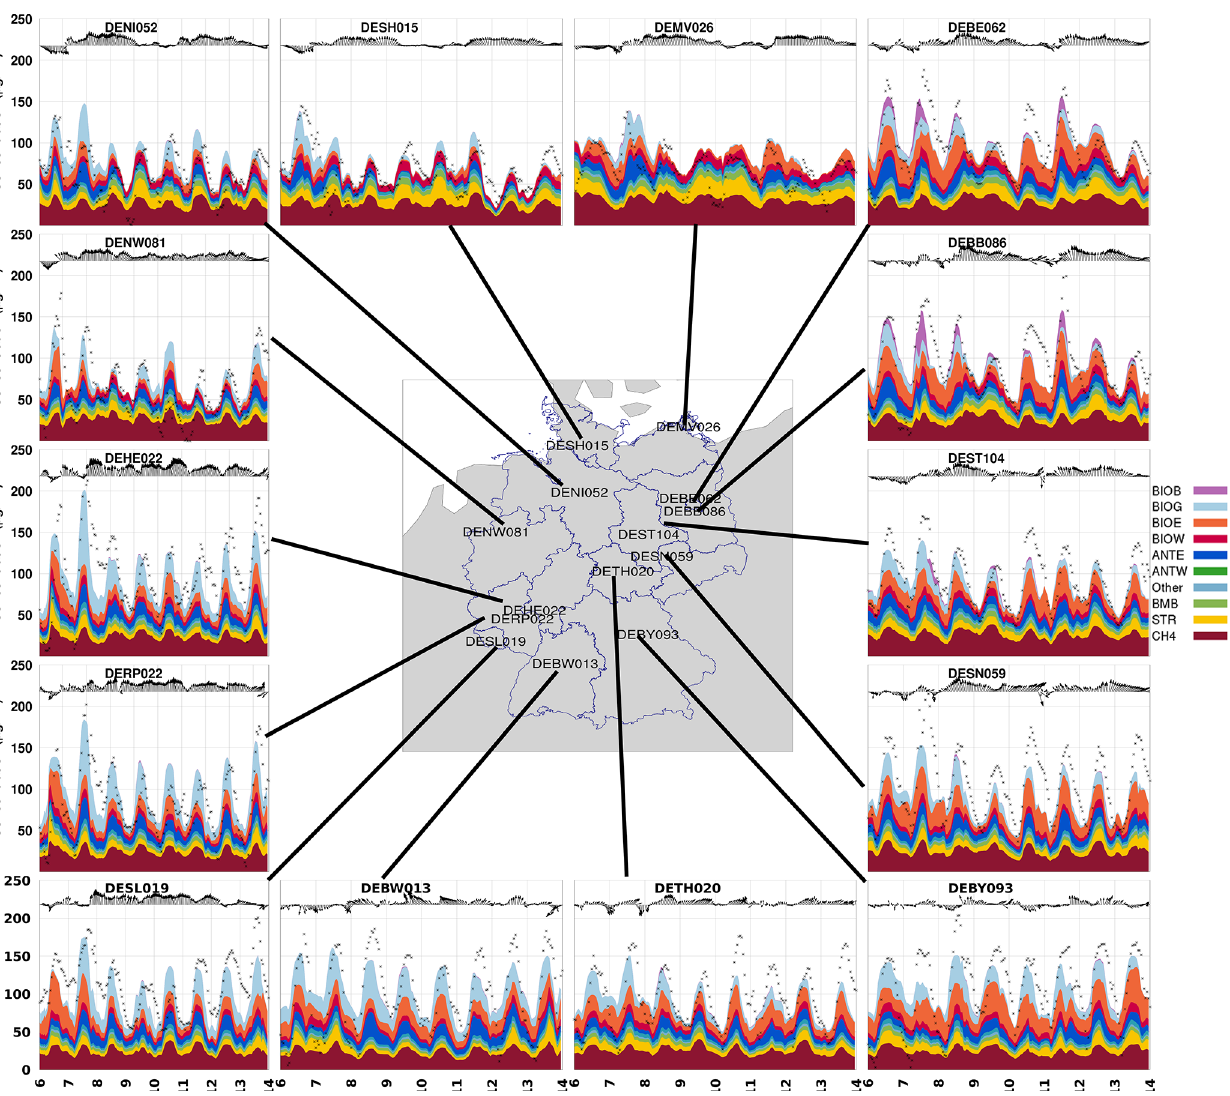
Figure 8. Contribution of regional VOC sources to hourly O 3 concentrations of local and other European sources, HTAP2 source regions, and other global source types at each station during the 6–13 August 2015 period. In addition, the vectors along the top of each panel represent the calculated wind speed and direction at 10ma.g.l. The black dots represent the observed O 3